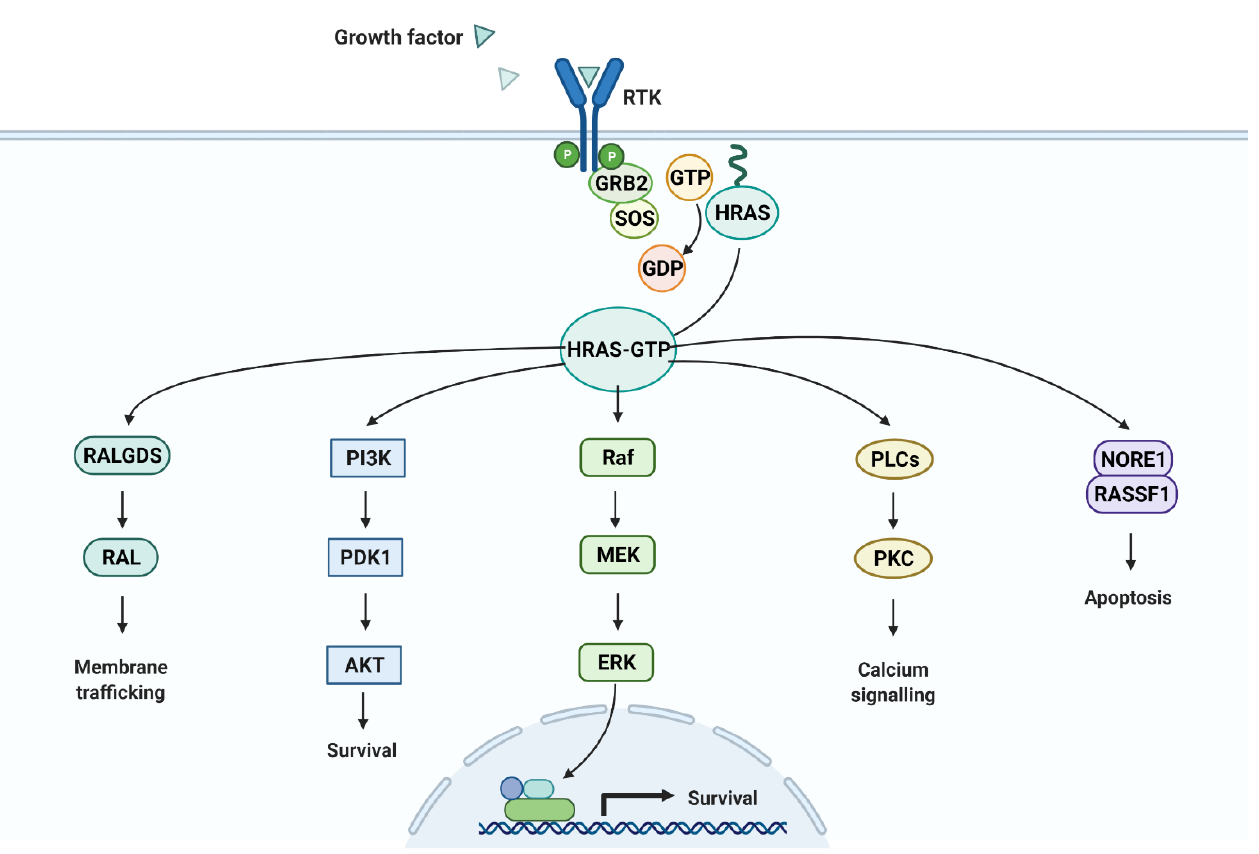
Figure 10. HRAS Pathways. The HRAS survival pathway including P13K and PDK1 has been extensively researched for its role in the proliferation of squamous cell